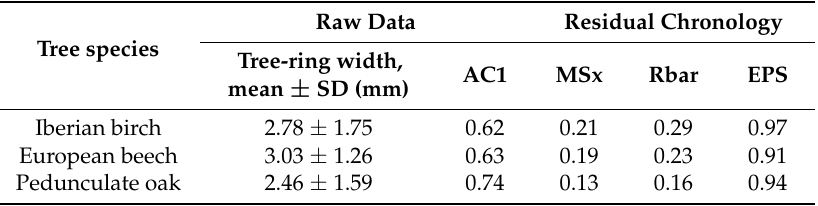
Table 2. Dendrochronological statistics of the mean chronologies for the three studied trees. The residual chronology statistics correspond to the 1977–2007 common period. Abbreviations: SD = standard deviation, AC1 = first-order autocorrelation, MSx = mean sensitivity, Rbar = mean correlation coefficient among tree-ring series, and EPS = expressed population